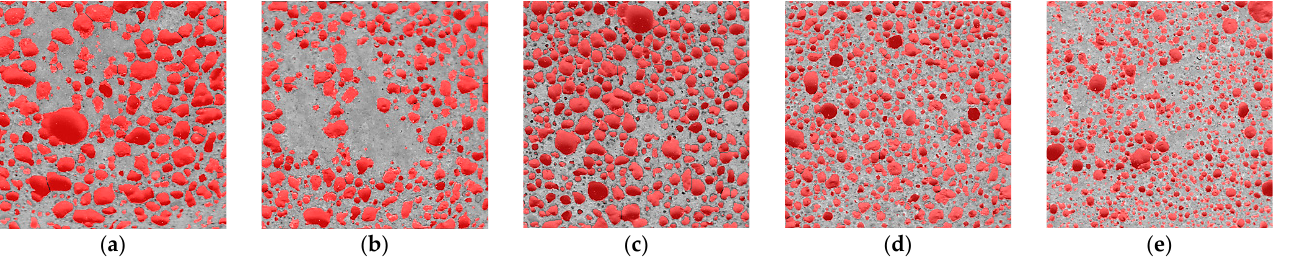
Figure 12. Pores and their distribution shown in specimen cross-sectional cuts in the hardened ma- terial according to the mixture: ( a ) P0, ( b ) P3, ( c ) P5, ( d ) P7, ( e ) P10. The air voids of sample P0 of the mixture composition ranged from 0.0125 to 8 mm 2 , of which 21.4% were voids larger than 0.5 mm 2 . The determined area of the air voids in the cross-section was 47.5%. In the P10 sample mixture, the size of the air voids predomi- nates between 0.0125 and 4 mm 2 , with the largest proportion, 22.2%, consisting of 0.25 mm 2 pores (Figure 13). The cross-sectional area of the air voids was determined to be